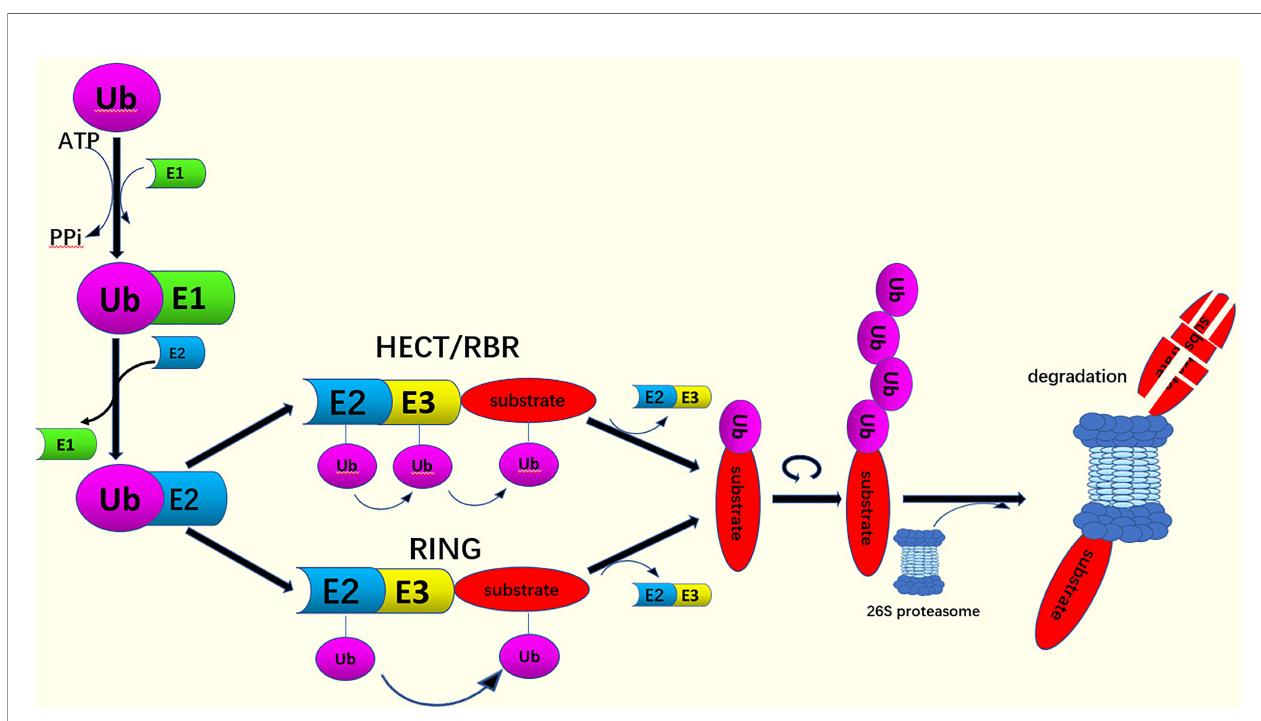
FIGURE 1 | The process of ubiquitination. Ub is activated by E1 through an ATP-dependent step. The activated Ub attaches to the E2. The binding of Ub to target proteins can be catalyzed by HECT and RBR-type E3 ligases, or RING domain E3 ligases. This acts as a bridge between the activated E2 and the substrate indicating that the ubiquitin signals form polyubiquitin chains. Finally, the substrate is degraded by the 26S